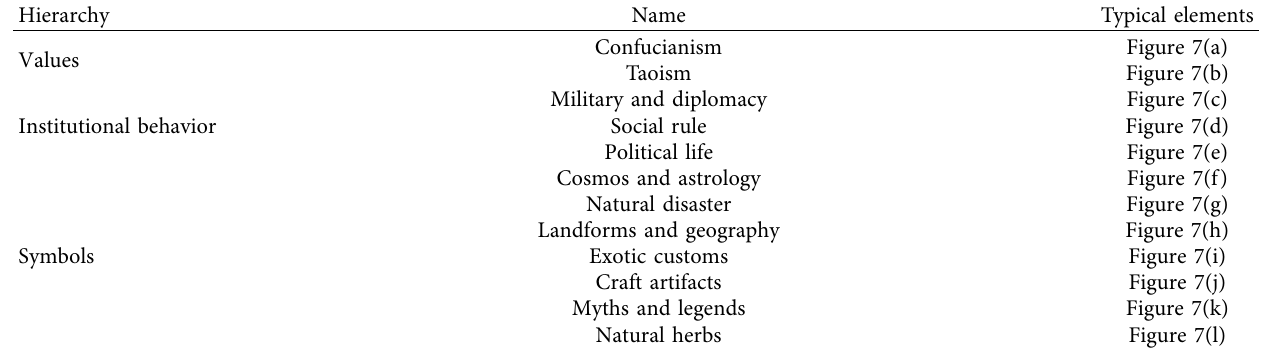
Table 7: Names and hierarchical structures of cultural topics.